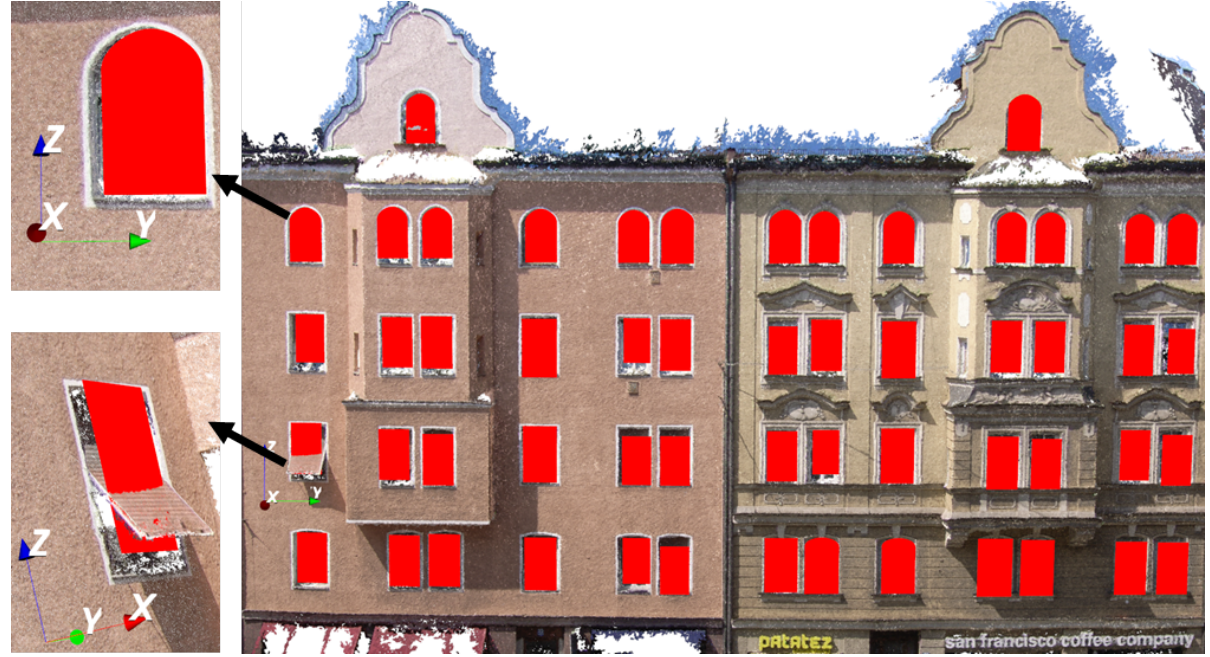
Figure 9: The diagram shows localization results of two different facades. The outlines filled in red giving 3D polygons represent windows and doors. The dimensions of window and door estimates may not be the same. This is because these estimates are from i.i.d random variables. This can be seen on three of the doors on the right facade.